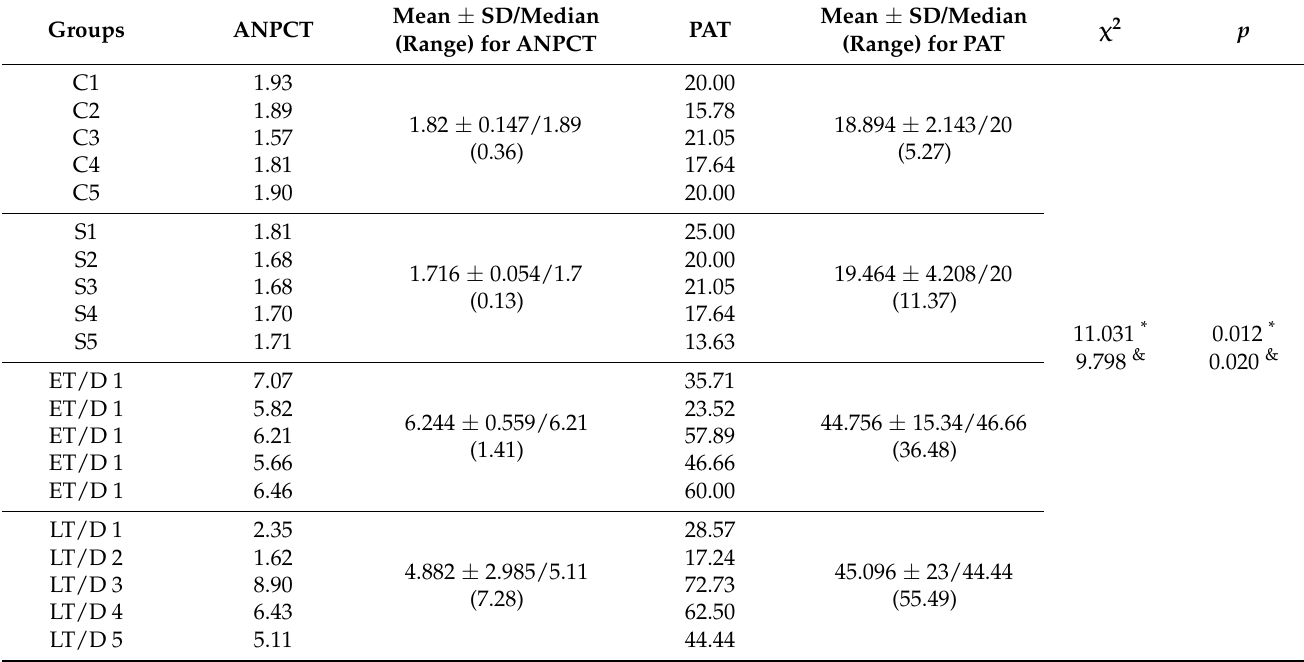
Table 4. The comparison of ANPCT and PAT in all groups.